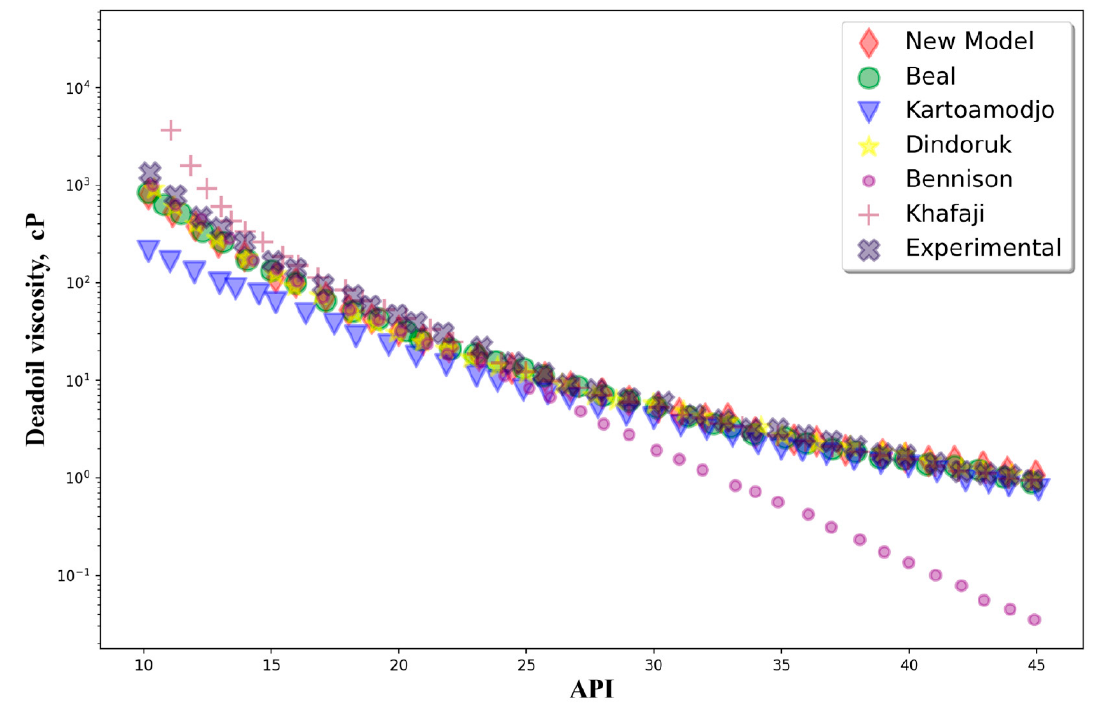
Figure 5. Dead oil viscosity from various correlations at various API at 120 °F.